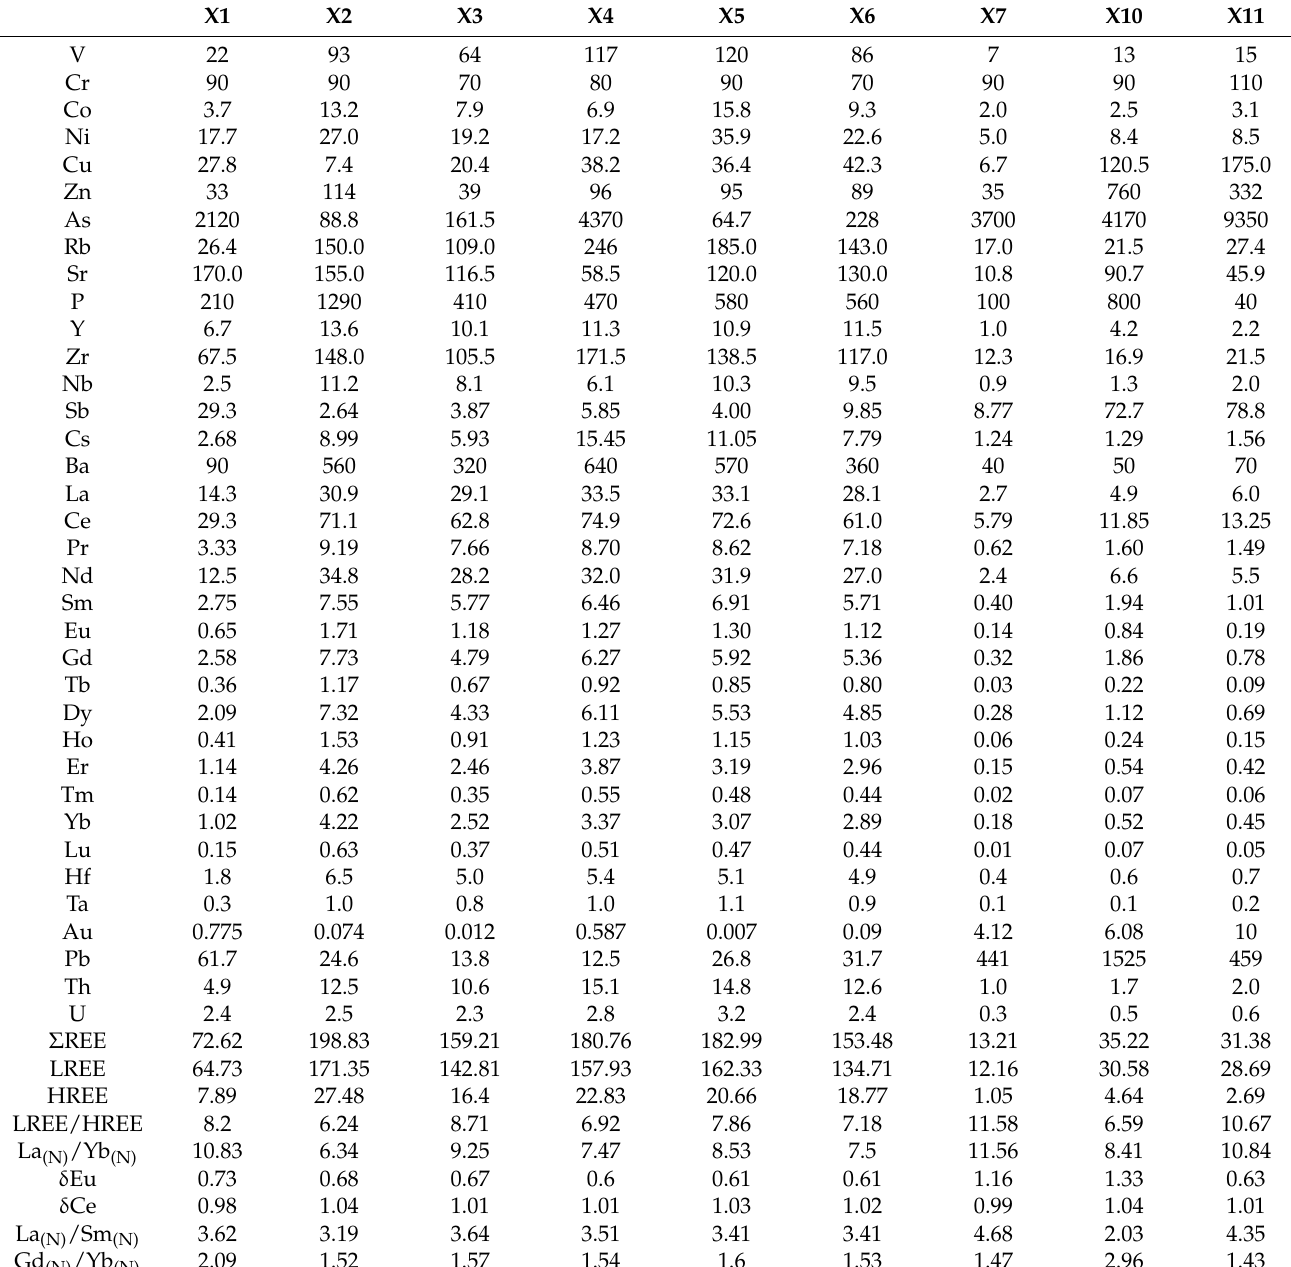
Table 2. Trace element contents (ppm) and parameters in Xiaojiashan gold